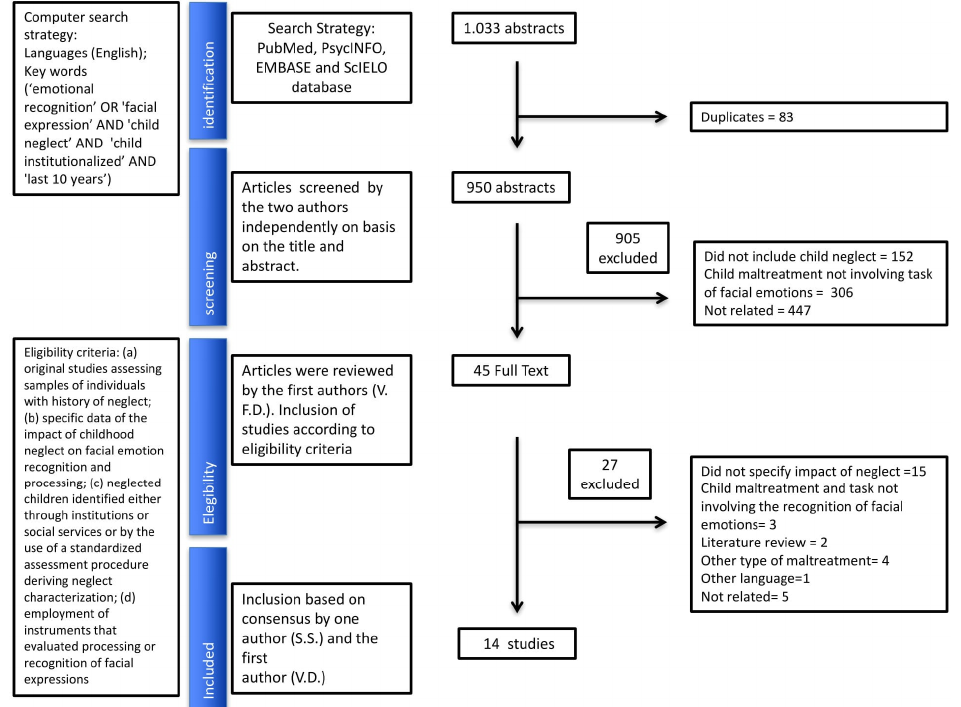
Figure 1. Flowchart of study selection process.